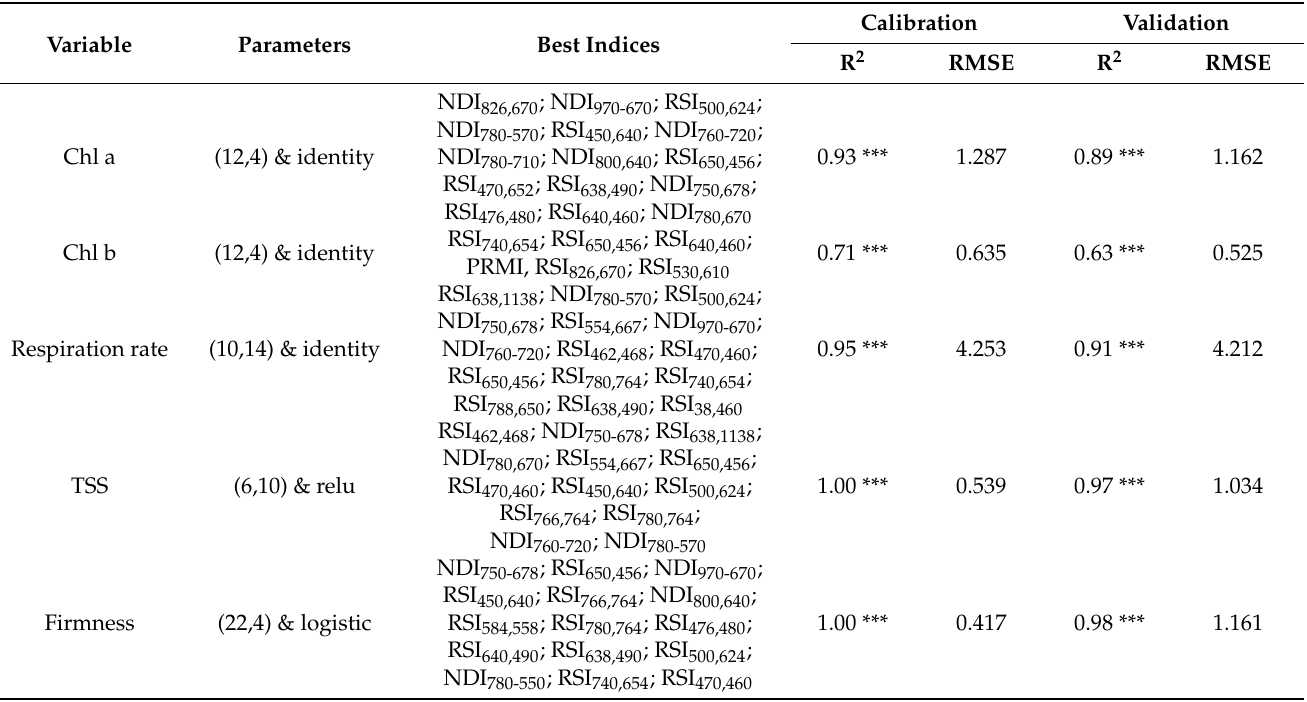
Figure 3. Neural network diagrams were established for detecting Chl a, Chl b, respiration rate, TSS, and firmness of banana fruits. Table 6. Results of ANN calibration and validation models for the relationship between SRIs and Chl a, Chl b, respiration rate, TSS, and firmness of banana